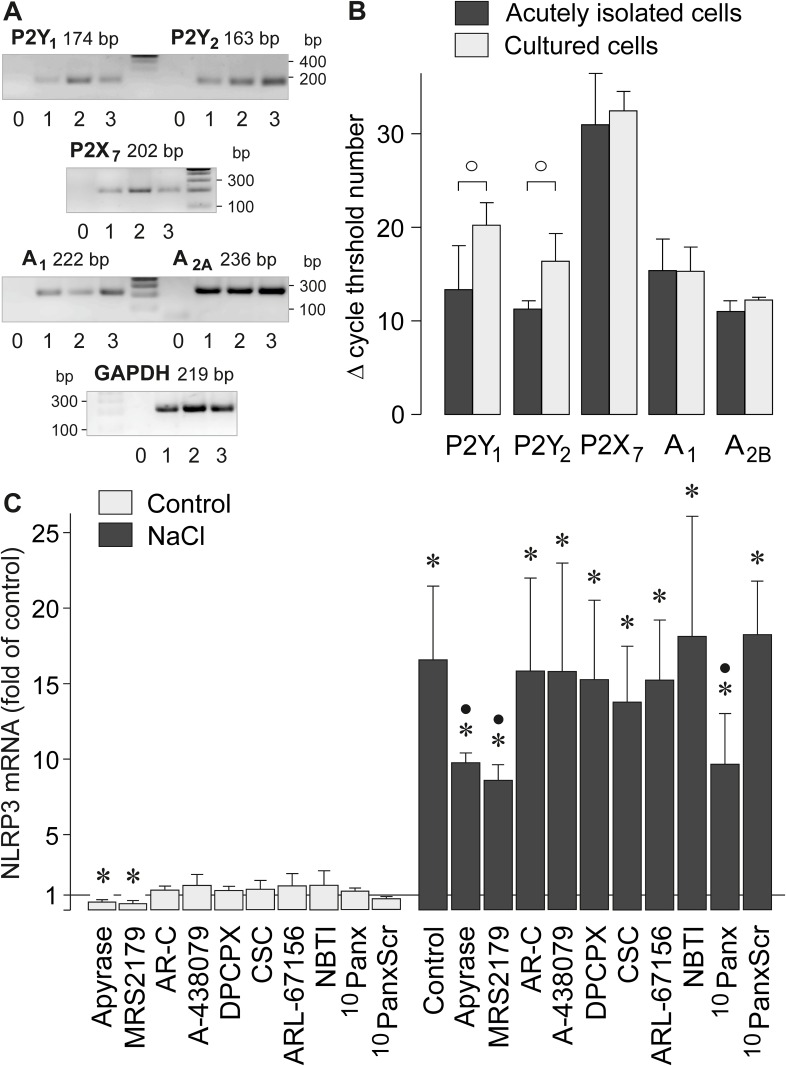
Involvement of P2Y1 receptor signaling in mediating the NaCl-induced expression of the NLRP3 gene in RPE cells.A. Presence of P2Y1, P2Y2, P2X7, adenosine A1 receptor, and adenosine A2B receptor gene transcripts in the cells. To confirm the correct lengths of PCR products, agarose gel electrophoresis was carried out using products obtained from cultured cells of the 4th passage (1) and from cells that were acutely isolated from eyes of two post-mortem donors without apparent eye diseases (2, 3). Negative controls (0) were done by adding double-distilled water instead of cDNA as template. B. Relative expression levels of the receptor genes in acutely isolated and cultured cells, as revealed by real-time RT-PCR. Each bar represents the cycle number necessary for the detection of the transcript. C. The level of NLRP3 mRNA was determined with real-time RT-PCR analysis in cells cultured 6 h in iso- (control) and hyperosmotic (+ 100 mM NaCl) media. The following agents were tested: the ATP/ADP phosphohydrolase apyrase (10 U/ml), the P2Y1 receptor antagonist MRS2179 (30 μM), the P2Y2 receptor antagonist AR-C 118925XX (AR-C; 10 μM), the P2X7 receptor antagonist A-438079 (50 nM), the adenosine A1 receptor antagonist DPCPX (50 nM), the adenosine A2A receptor antagonist CSC (200 nM), the ecto-ATPase inhibitor ARL-67156 (50 μM), the antagonist of nucleoside transporters, NBTI (10 μM), the pannexin-blocking peptide 10panx (200 μM), and the scrambled control peptide 10panxScr (200 μM). Means ± SEM of 3–6 independent experiments using cell lines from different donors. Significant difference vs. unstimulated control: *P<0.05. Significant difference vs. NaCl control: ●P<0.05. ○P<0.05.